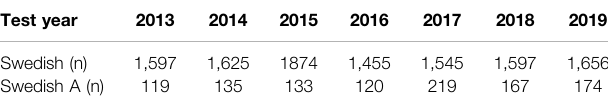
TABLE 1 | Number of collected results and the distribution between students taking the course Swedish and Swedish A,